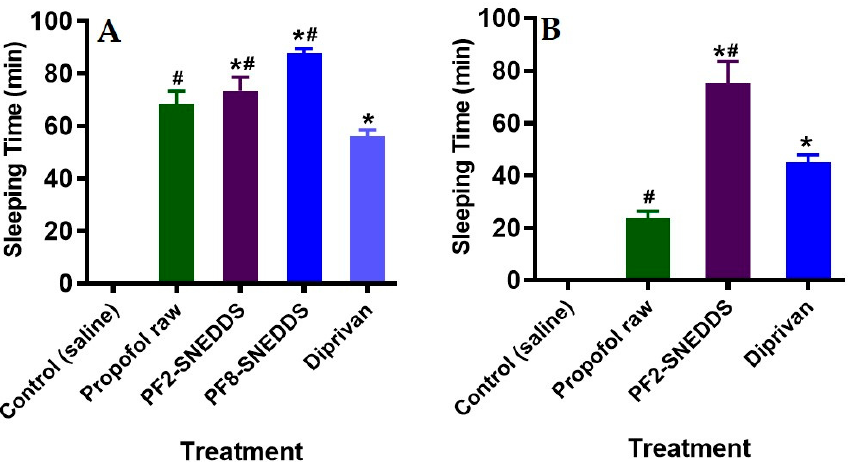
Figure 9. Measurement of propofol-induced sleeping time in rats (n = 6). ( A ) An equivalent dose of 10 mg/kg was administered intravenously to all the treatment groups (propofol raw, propofol-loaded formulation PF2-SNEDDS, PF8-SNEDDS, and marketed drug Diprivan ® ). ( B ) The dose (propofol raw, propofol-loaded formulation PF2-SNEDDS, and marketed drug Diprivan ® ) was administered intraperitoneally (IP). All results are presented as the average ± SEM. The asterisk and hash symbols (above the bars) indicate significant differences between samples * p < 0.05 (Propofol raw); # p < 0.05 (Diprivan ® ).